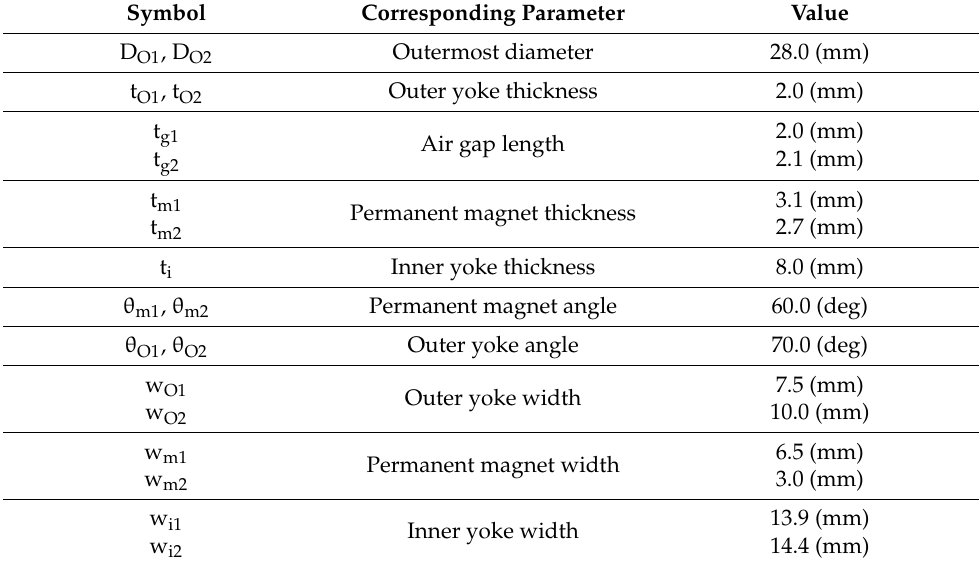
Figure 4. Y-Z cross-section of original 3-DOF spherical motor when the rotor is rotating around the X -axis at ( a ) 0° and ( b ) 25°, respectively.